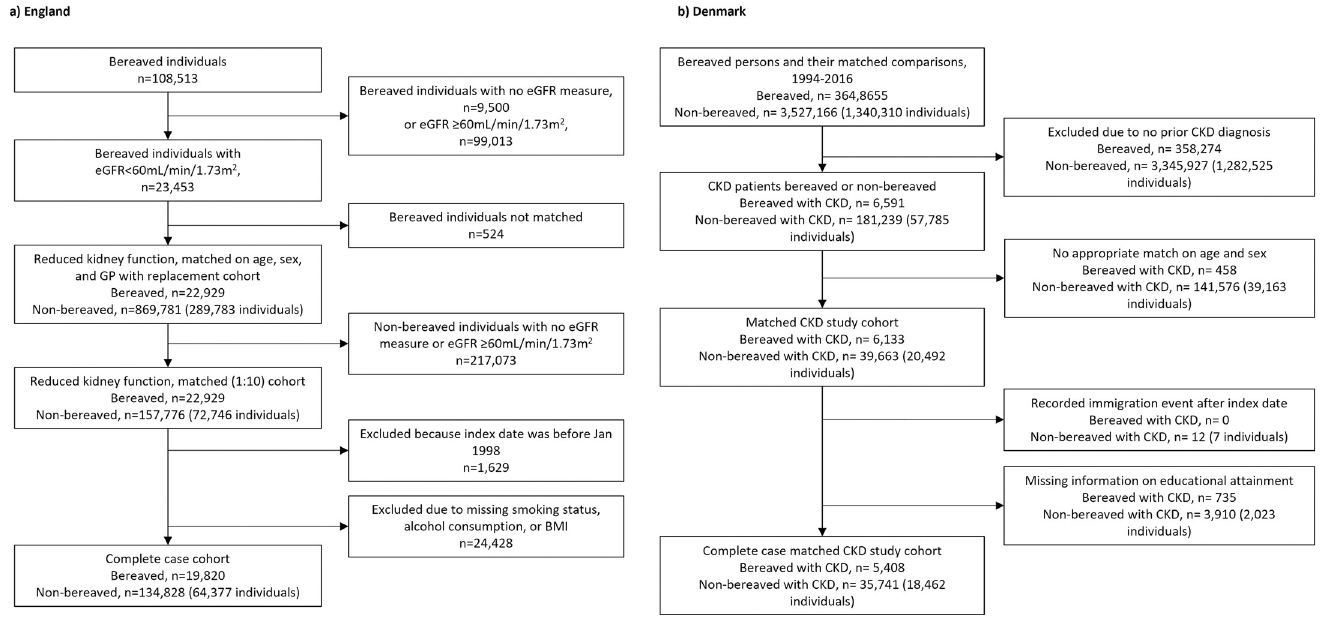
Fig 1. Flow diagram of cohort sampling in England (1a) and Denmark